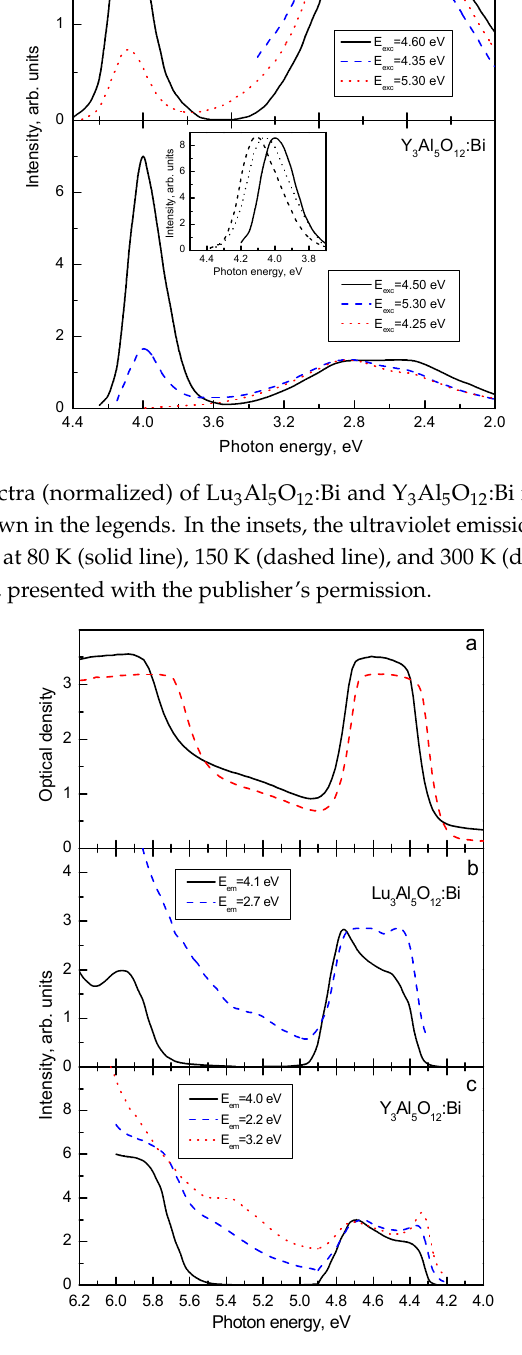
Figure 3. ( a ) Temperature dependences of the UV emission band maximum position in Y 3 Al 5 O 12 :Bi (solid line) and Lu 2 SiO 5 :Bi (dashed line), ( b ) the FWHM of the UV emission band in Lu 2 SiO 5 :Bi, and ( c ) the maximum intensities of the UV (4.0 eV, solid line) and VIS (2.5 eV, dashed line) emissions in Y 3 Al 5 O 12 :Bi reported in [17,18,21], presented with the publisher’s permission.